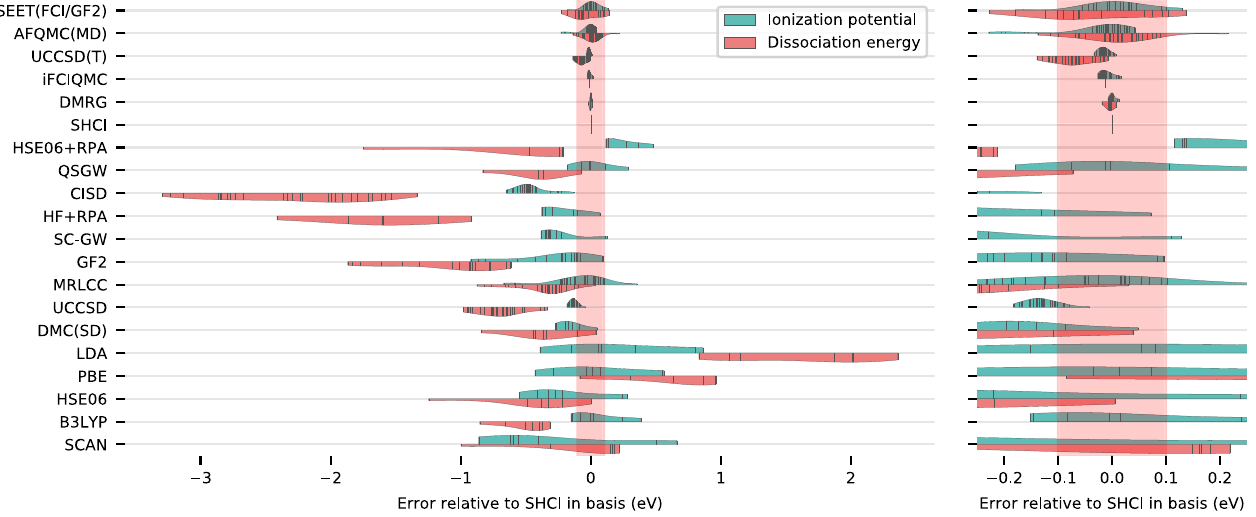
FIG. 3. Kernel density estimation plot of the dissociation energy and ionization potential of molecules and atoms to SHCI reference calculations. Methods are ordered according to the clustering in Fig.